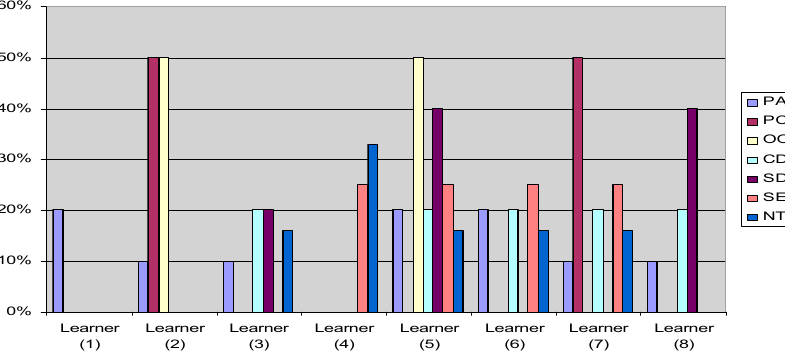
Figure 22. Learners’ participation ratio graph for Group 1.